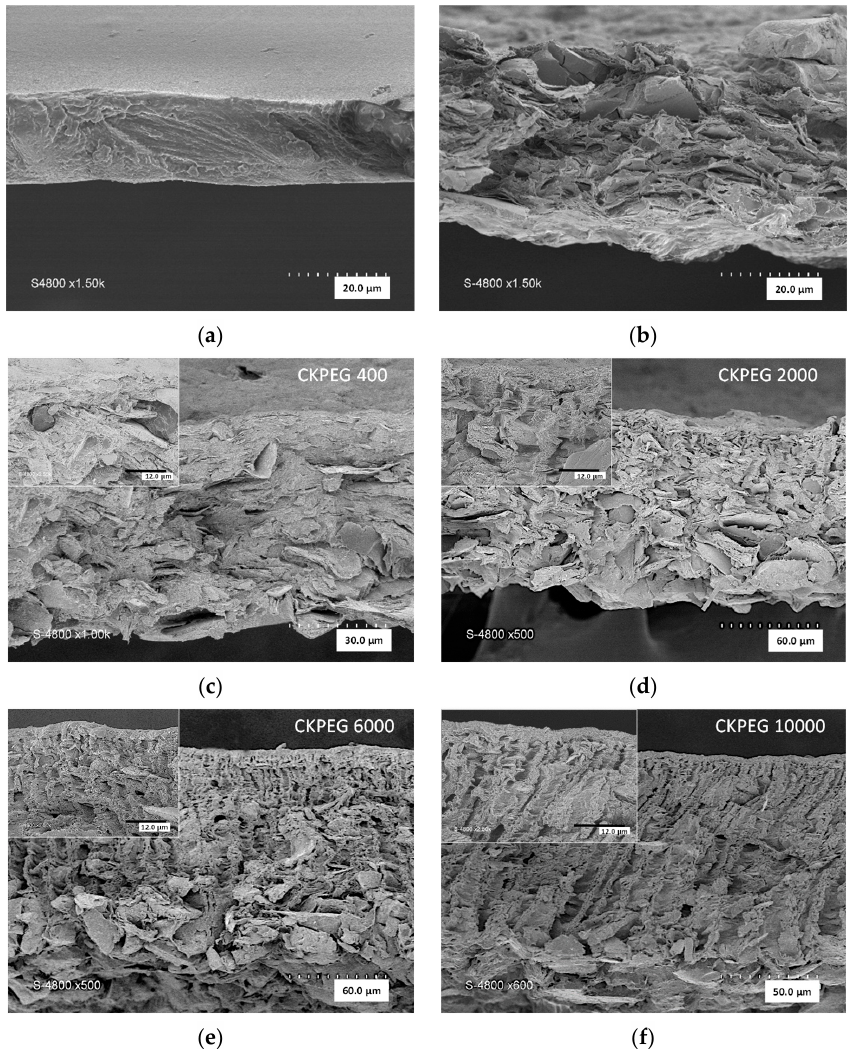
Figure 3. SEM Cross-sectional images of membranes prepared from: ( a ) pure CS membrane (×1500); ( b ) CS/KO (×1500); ( c ) CS/KO/PEG-400 (×1000); ( d ) CS/KO/PEG-2000 (×500); ( e ) CS/KO/PEG-6000 (×500); ( f ) CS/KO/PEG-10000 (×600). Insets are magni fi cations showing the sponge-like top layer. Magni fi cation, ×2500; scale bar, 12 µm.